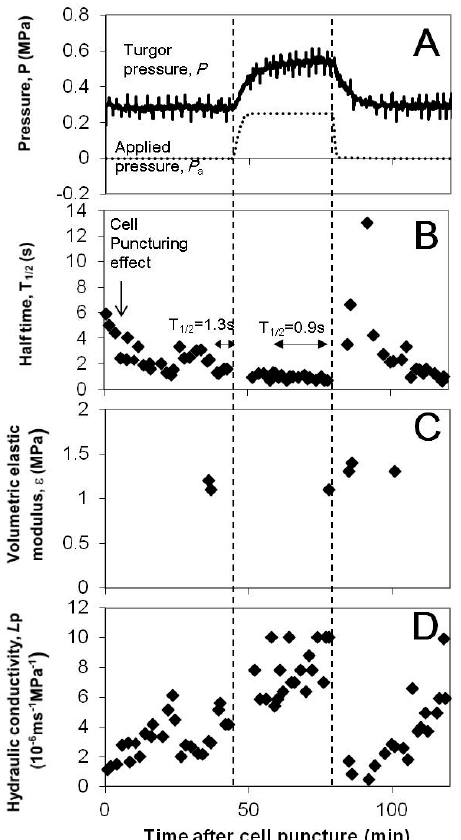
Figure 3. ( A ) Temporal variations of the leaf cell turgor ( P ; solid curve) and the pressure applied to the pressure chamber ( P a ; dashed curve). The atmospheric pressure is zero. Time zero is when a cell was punctured by a capillary of a cell pressure probe. The vertical lines indicate the duration of increment of 0.25 MPa at the first dashed line, and the cell turgor pressure was increased by